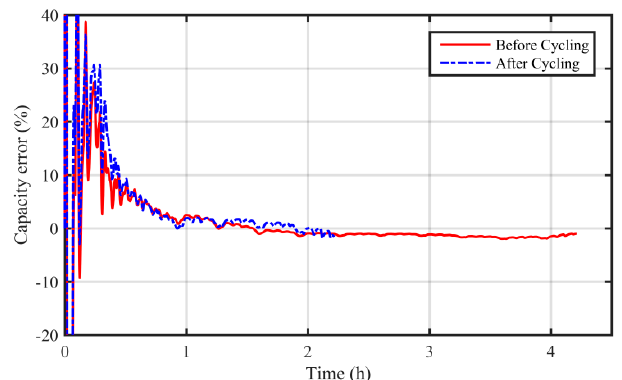
Figure 8. Relative error of capacity estimation with the proposed method (the 0% line means perfect estimation without error). Table 3. Performance of the proposed method on voltage prediction and SOC estimation for the hybrid pulse experiment.